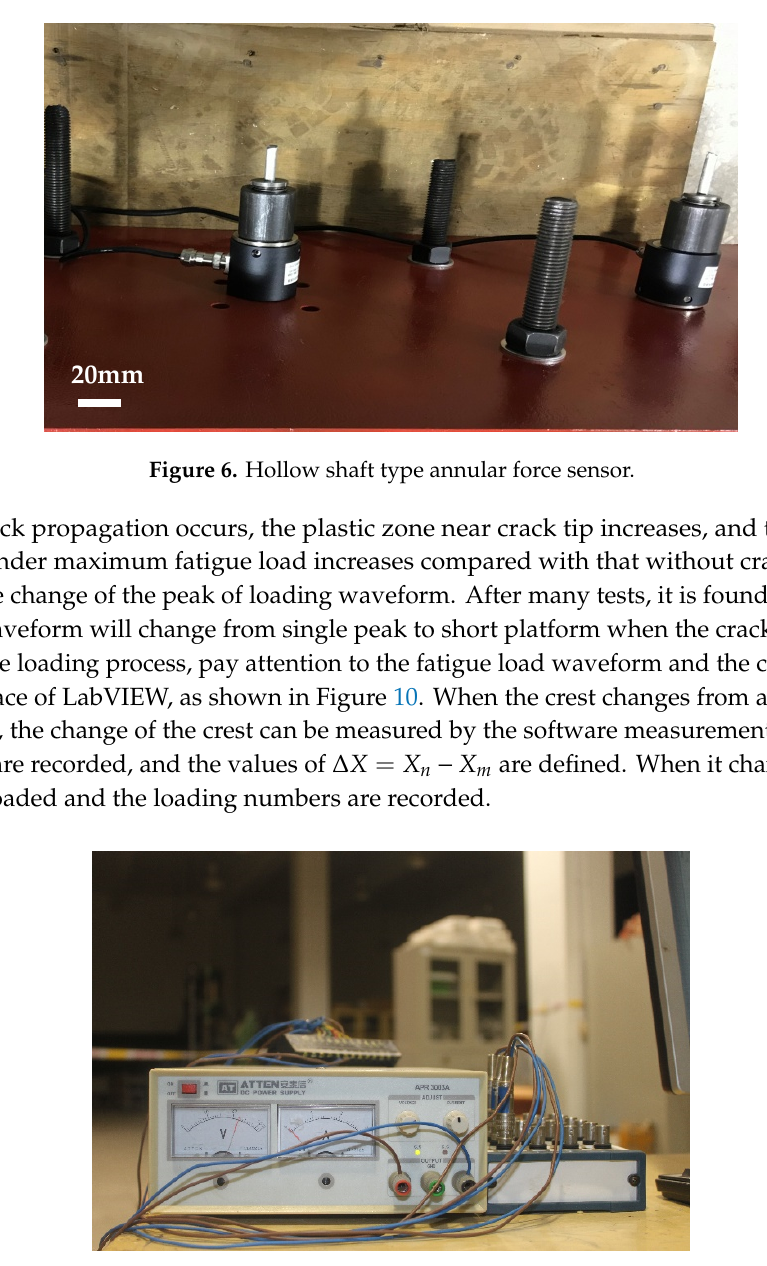
Figure 7. Acquisition device—National Instruments BNC-2111.